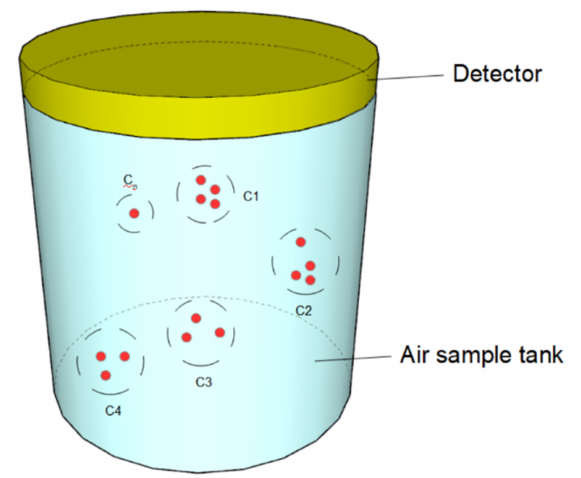
Figure 7. Volumetric cluster cells in 3D—’The Babi Mini